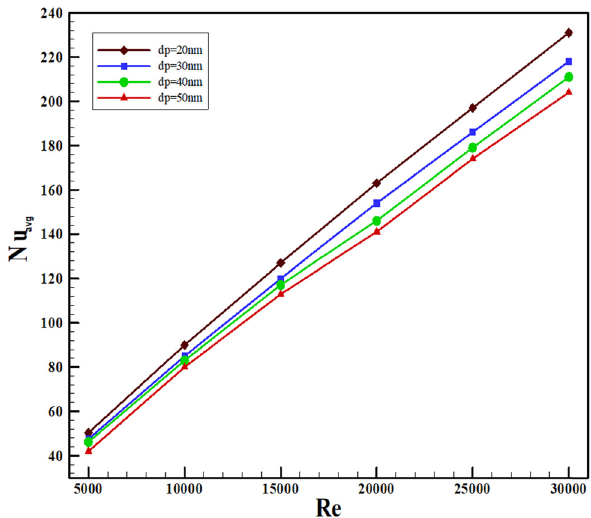
Figure 7: Average Nusselt number and Reynolds number variation for various diameters of SiO 2 nanoparticles of water/SiO 2 nano fl uid with ϕ = 0.04.